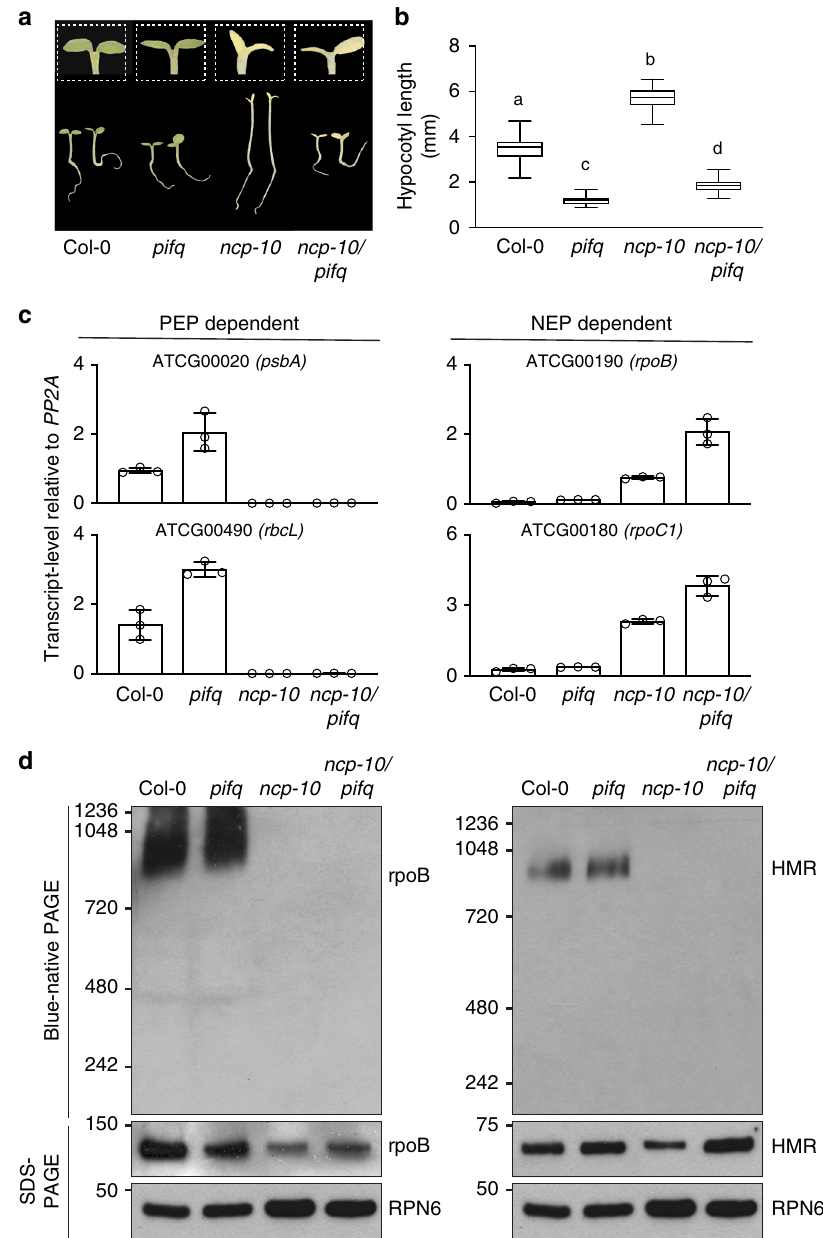
Fig. 4 NCP promotes the assembly and activation of the PEP in plastids. a A ncp-10/pifq mutant rescues the long hypocotyl phenotype, but not the albino phenotype, of ncp-10 . Left panel: representative images of 4-day-old Col-0, pifq , ncp-10 , and ncp-10/pifq seedlings grown in 10 μ mol m − 2 s − 1 R light. Inlets show magni fi ed images of embryonic leaves of one of the corresponding seedlings below. b Box-and-whisker plots showing hypocotyl length measurements for the seedlings in a . The boxes represent from the 25th to the 75th percentiles, and the bars represent the median values. Samples with different letters have statistically signi fi cant differences in hypocotyl length (ANOVA, Tukey's HSD, p ≤ 0.001, n > 30). c qRT-PCR analyses of the transcript levels of selected PEP-dependent and NEP-dependent genes in 4-day-old Col-0, pifq , ncp-10 , and ncp-10/pifq seedlings grown under 10 μ mol m − 2 s − 1 R light. Transcript levels were calculated relative to those of PP2A . Error bars represent SD of three biological replicates. d Immunoblots showing the level of the PEP complex (blue-native PAGE), as well as the levels of rpoB and HMR proteins (SDS-PAGE) in 4-day-old Col-0, pifq , ncp-10 , and ncp-10/pifq seedlings grown in 10 μ mol m − 2 s − 1 R light using antibodies against rpoB or HMR. RPN6 was used as a loading control. The source data underlying the hypocotyl measurements in b , the qRT-PCR data in c , and the immunoblots in d are provided in the Source Data fi